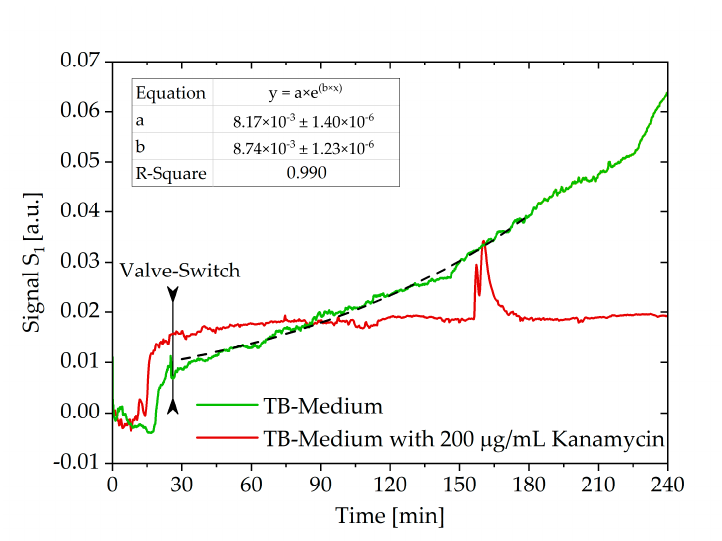
Figure 7. Time course of the diffraction signal of growth experiments with and without the addition of 200 µg/mL kanamycin with an exponential fit to determine the bacterial growth rate in the experiment without kanamycin.